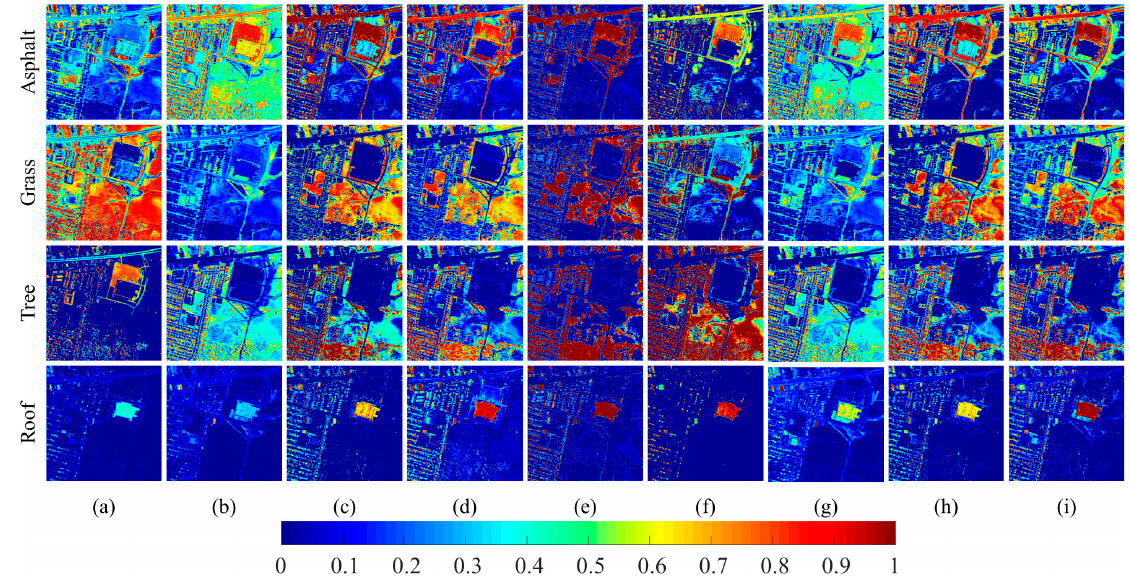
Figure 17. Visualization results of the abundances of Urban data. ( a ) VCA-FCLS. ( b ) SGCNMF. ( c ) DAEU. ( d ) MTAEU. ( e ) CNNAEU. ( f ) CyCU-Net. ( g ) MiSiCNet. ( h ) SSANet. ( i ) GT.